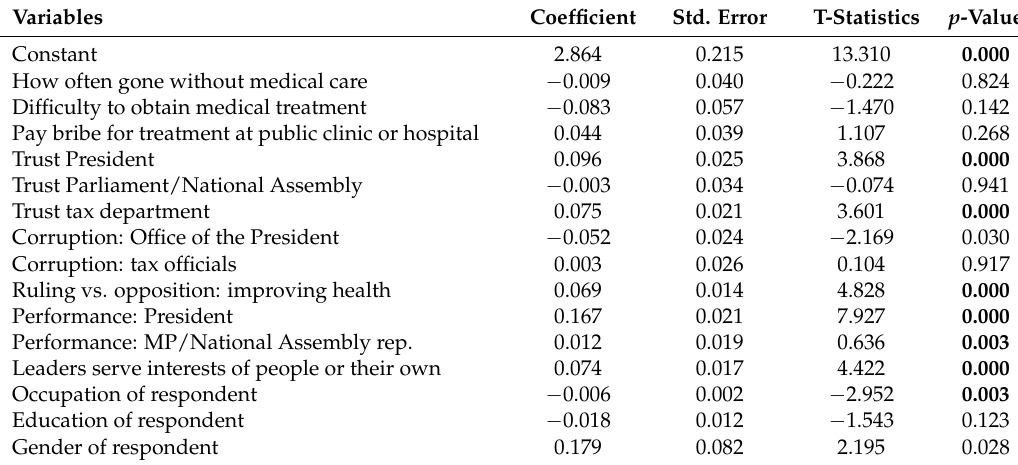
Table 6. A multiple linear regression analysis showing relationship between public perceptions and support for